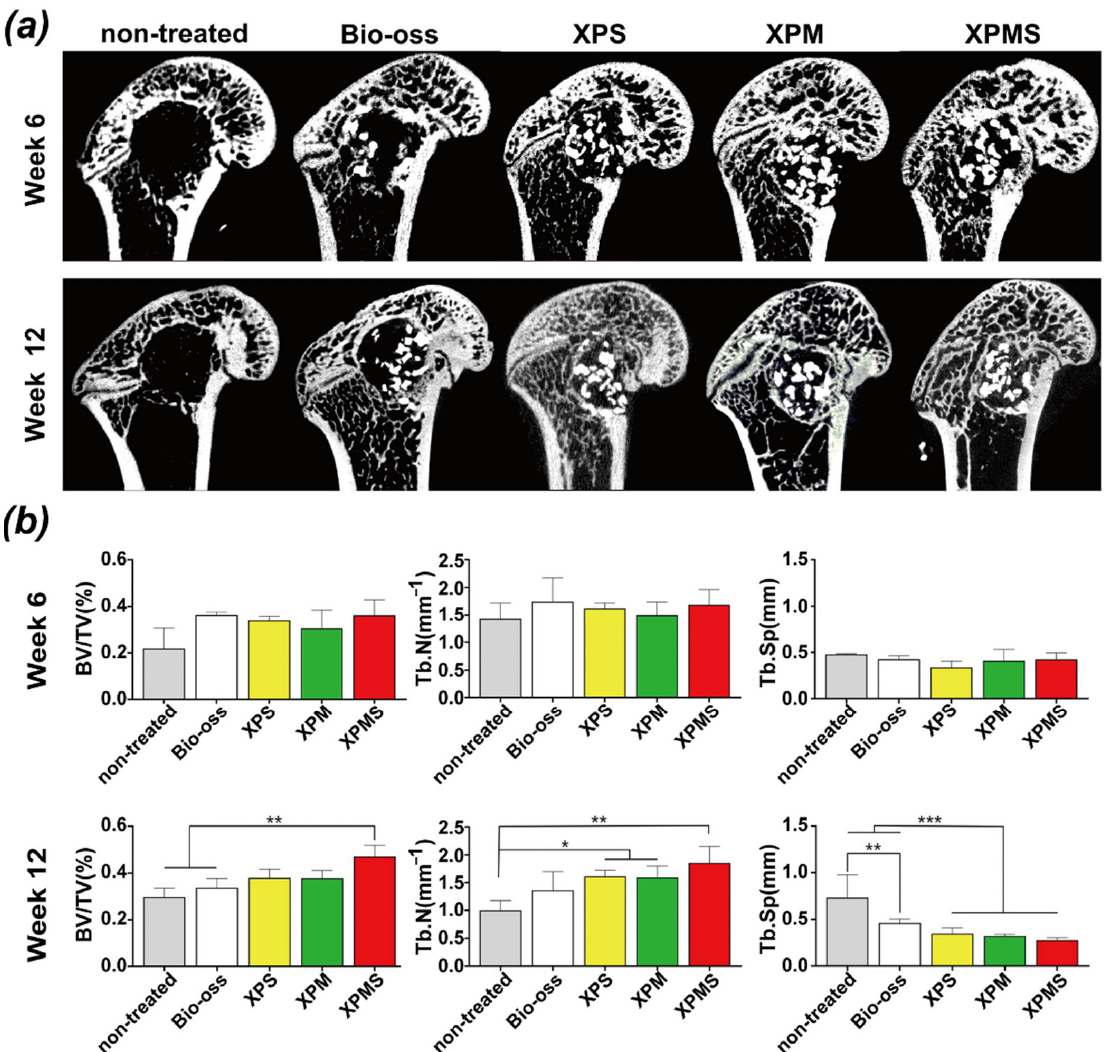
Figure 6. In vivo bone regeneration after 6 and 12 weeks of implantation of XPMS hydrogel on femoral defect. ( a ) Micro-CT images of femoral defects after implantation of different hydrogels scaffold groups for 6 and 12 weeks; ( b ) quantitative evaluations of bone parameters for 6 and 12 weeks, indicating the bone regeneration capability of different hydrogel scaffolds based on histo- morphometric micro-CT analysis. * p < 0.05, ** p < 0.01, and *** p < 0.001.